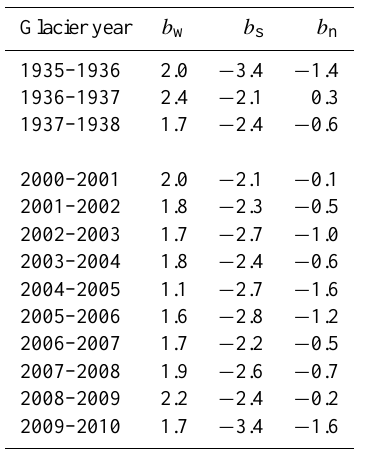
Table 1. Specific winter ( b w ), summer ( b s ) and net balance ( b n ) for Hoffellsjökull in m w . e . a − 1 . A conservative error estimate is on the order of 15–20% for both b w and b s .